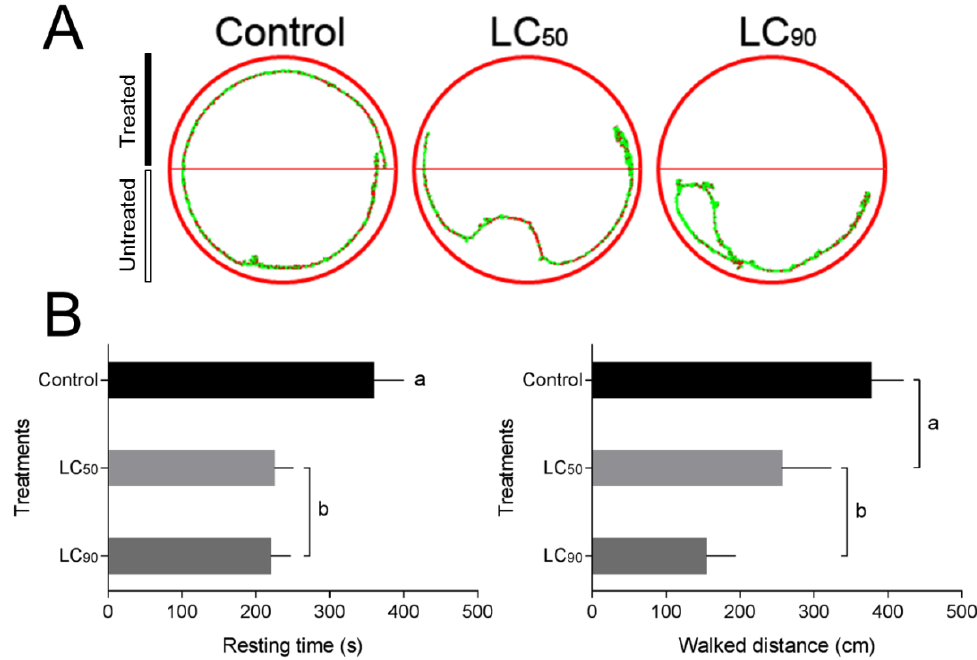
Figure 2. Behavior response of Spodoptera frugiperda caterpillars caused by deltamethrin. ( A ) Rep- resentative tracks showing the walking activity of S. frugiperda over a 10-min period on filter paper arenas half-impregnated with deltamethrin (upper half of each arena). Red tracks indicate high walking velocity; green tracks indicate low (initial) velocity. ( B ) Resting time and distance walked of S. frugiperda subjected to deltamethrin (control, LC 50 , and LC 90 estimated values) for 10 min. Treatments (mean ± SEM) differ at p < 0.05 (Tukey’s mean separation test).